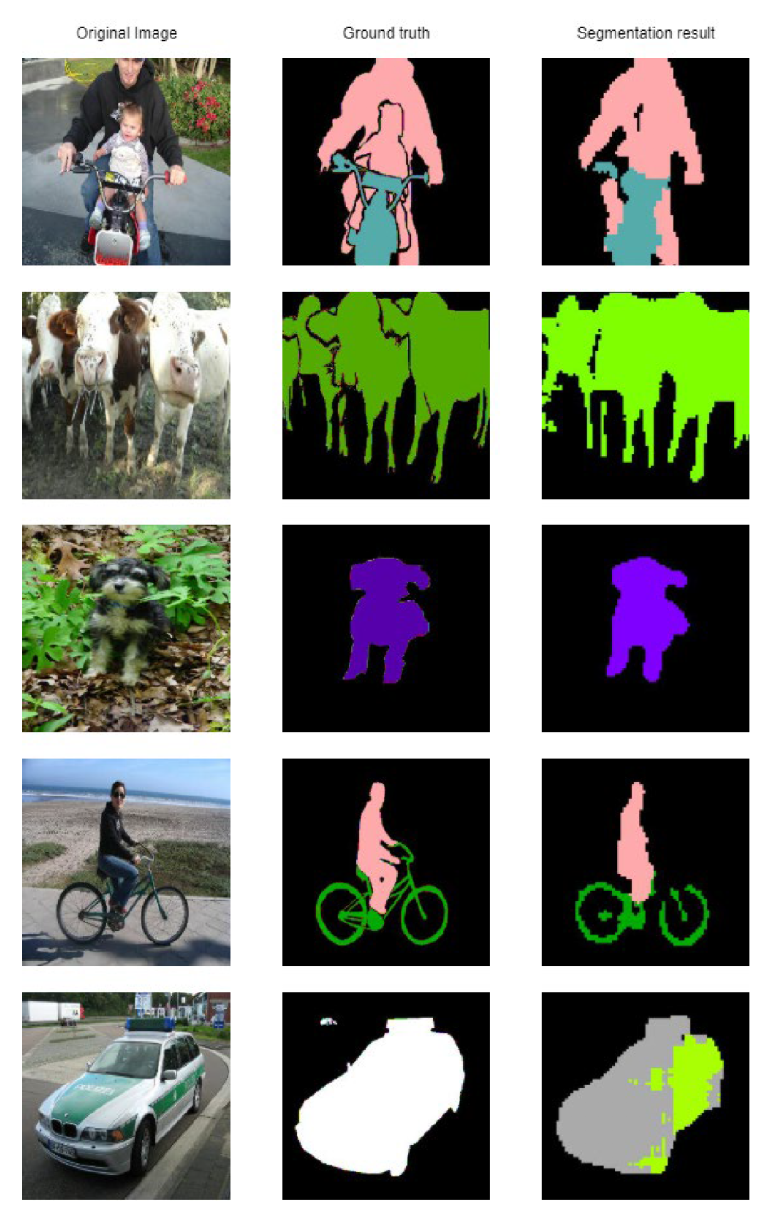
Figure 5. Segmentation result on classes on the Pascal VOC 2012 dataset